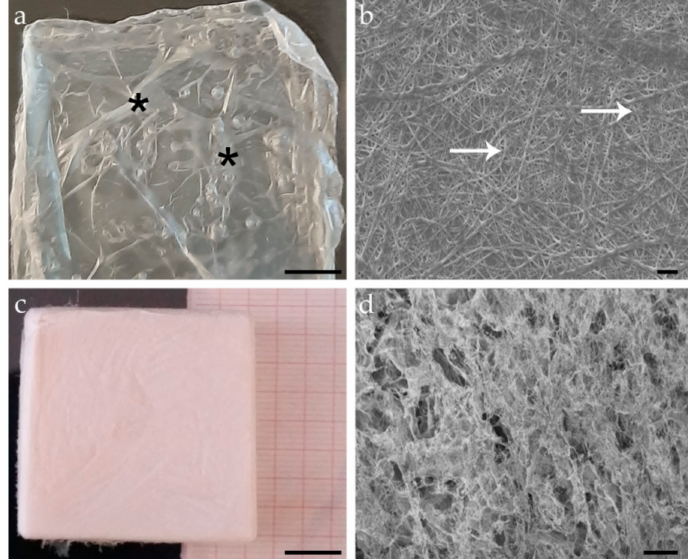
Figure 1. Examples of 2D membranes and 3D scaffolds of sea urchin-derived collagen. ( a ) Top view of a 2D membrane (light microscopy). Asterisks mark macroscopic folds of the thin 2D membrane. ( b ) Micrograph of a 2D membrane where the random distribution of the single collagen fibrils (arrows) in the two-dimensional network is visible (scanning electron microscopy). ( c ) Top view of a 3D scaffold (light microscopy). ( d ) Micrograph of a 3D scaffold where the porous microstructure of the biomaterial is detectable (scanning electron microscopy). Scalebar: ( a ) = 500 µ m; ( b ) = 2 µ m; ( c ) = 1 cm; ( d ) = 200 µ